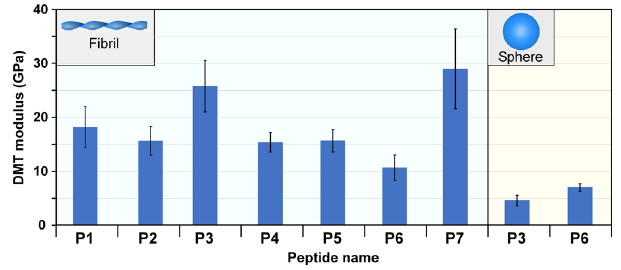
Fig. 4 Nanomechanics of supramolecular peptide assemblies. Relationship between the DMT modulus (GPa) and the morphology of the self-assembled P1 – P7 peptides. Error bars